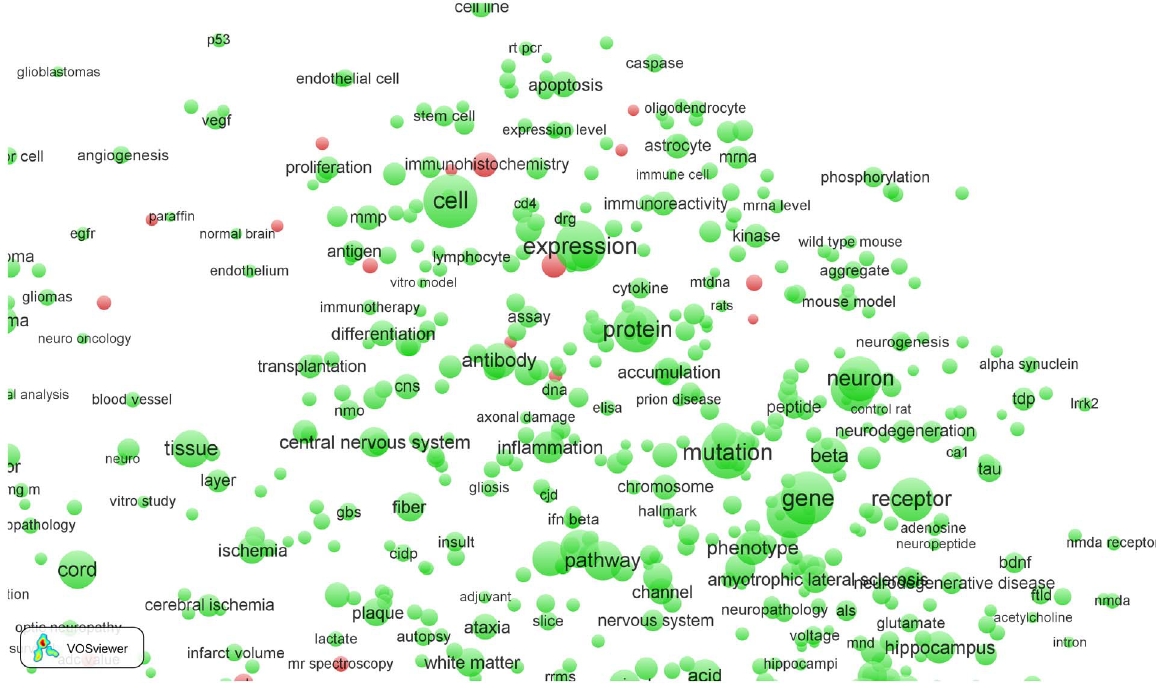
Figure 4. Term map of the Clinicalneurology field after zooming in into the basic science subfield.